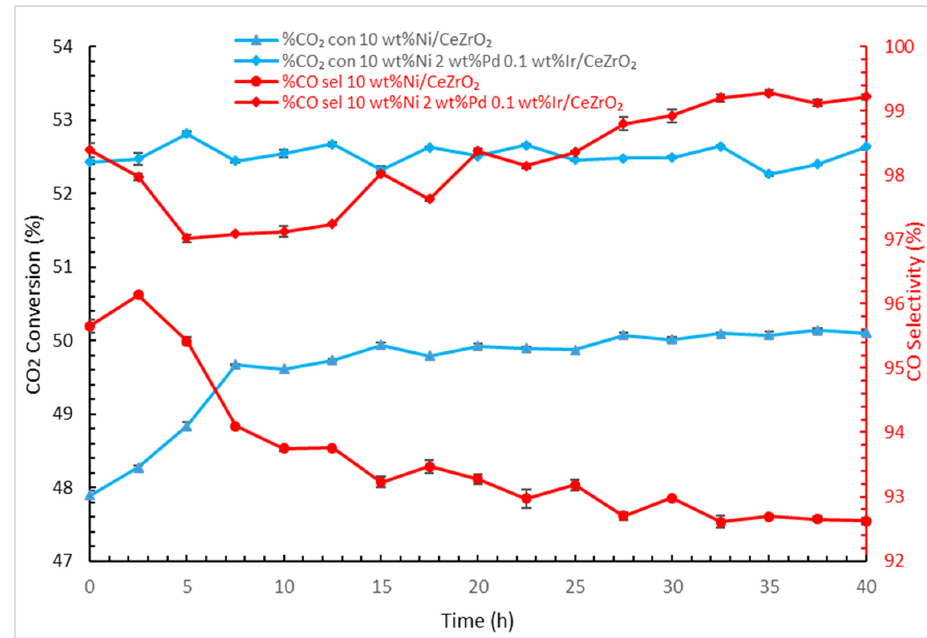
Figure 3. CO 2 conversion and CO selectivity of 10 wt%Ni 2 wt%Pd 0.1 wt%Ir/CeZrO 2 and 10 wt%Ni/CeZrO 2 catalysts at 750 °C and 1 bar pressure.